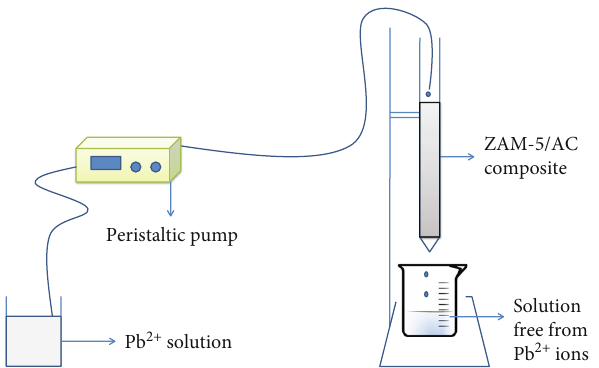
Figure 1: Schematic diagram fi xed-bed column setup for the removal of Pb 2+ ions by ZSM-5/AC